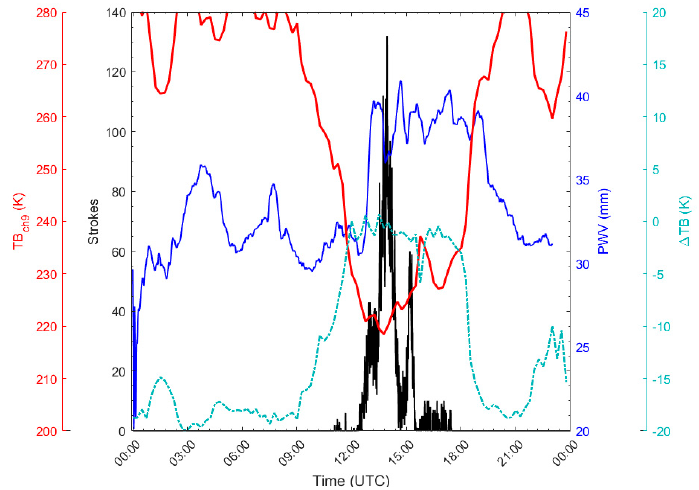
Figure 9. Trend of total number of strokes (black line), PWV (blue line), TB ch9 (red line), and ∆ TB (dashed sky blue line) for the whole day of 2nd September 2018 over the Pineto area.